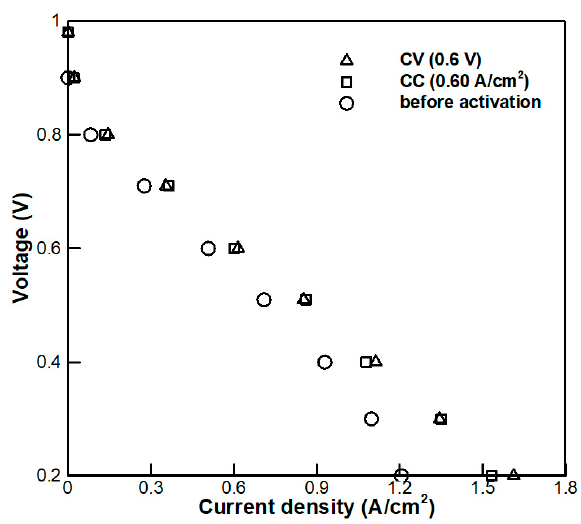
Figure 5. Comparison of PEM fuel cell performance after conditioning between CC and CV modes.